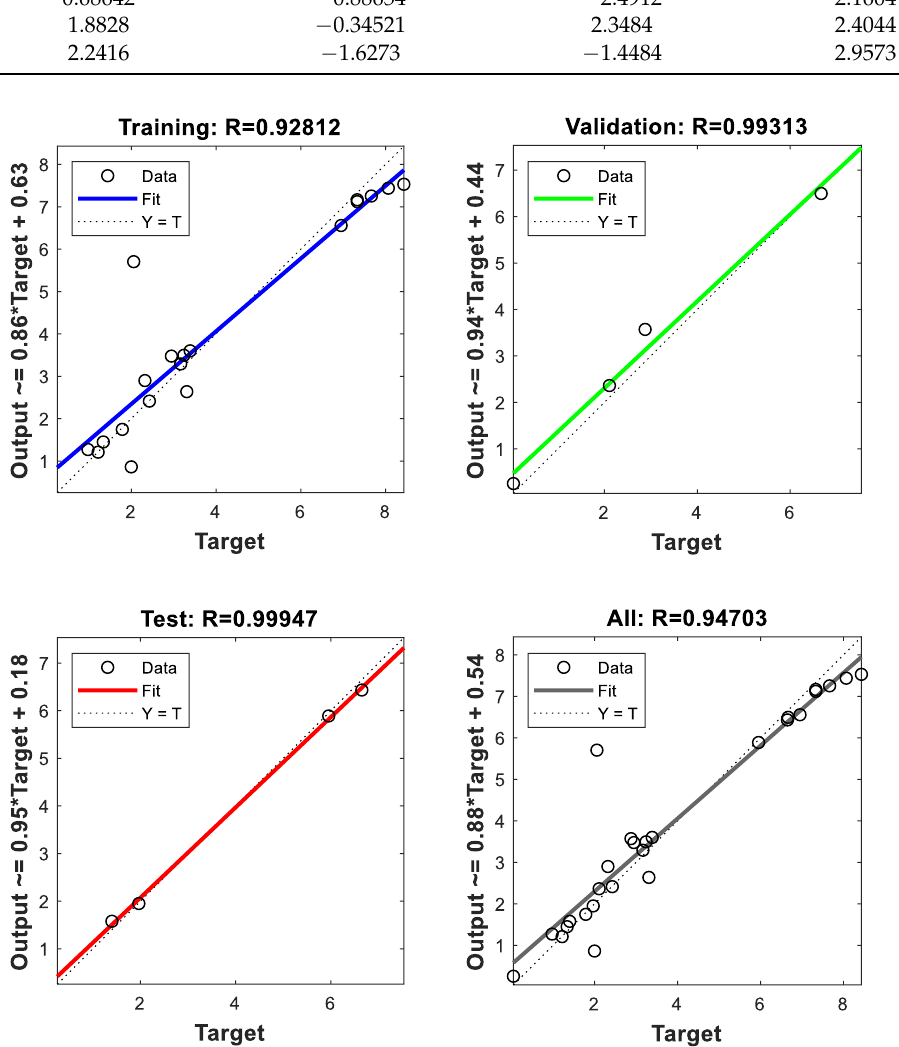
Figure 15. R-values for training and testing data sets.